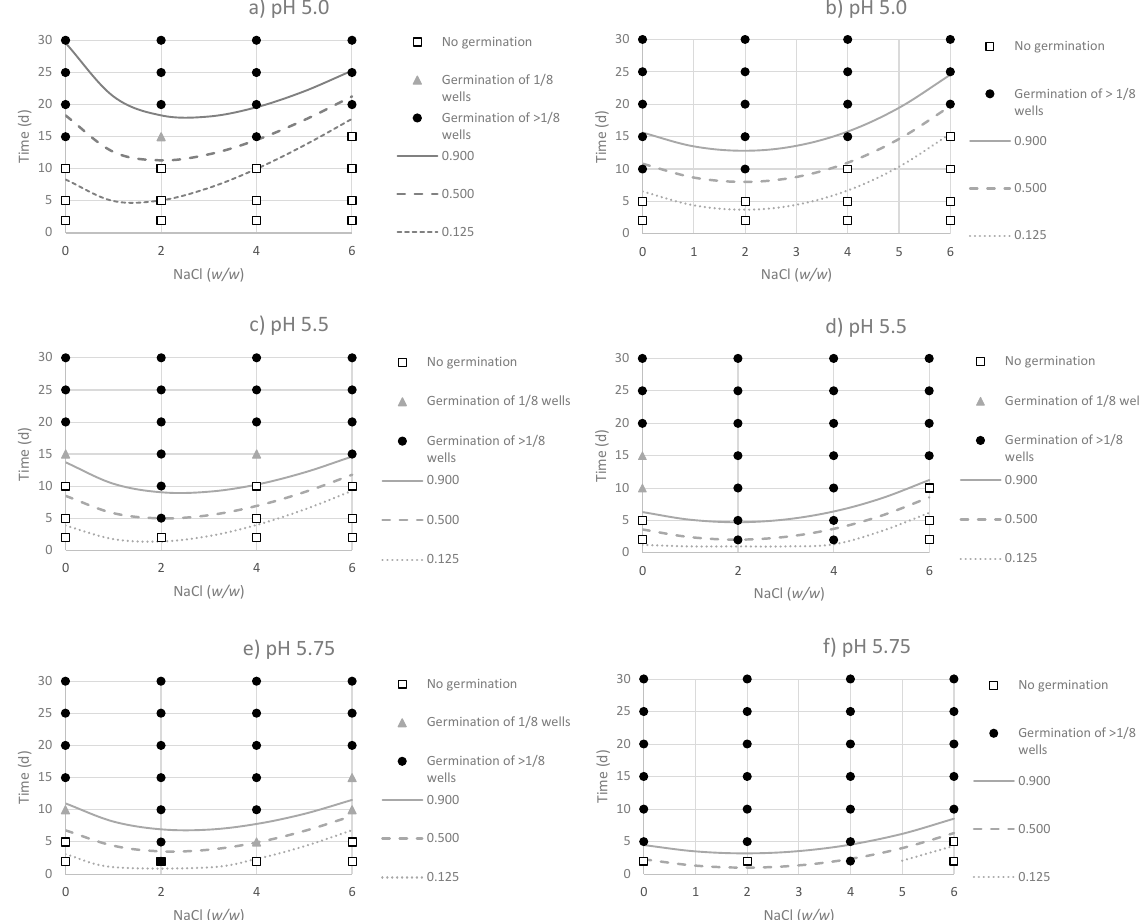
Figure 1. Contour plots for the observed germination responses and predicted probabilities ( p = 0.125, p = 0.500 and p = 0.900) for the non-adapted (panels a , c , e ) and acid-adapted strains (panels b , d , f ) of C. sporogenes at pH levels 5.0, 5.5 and 5.75.